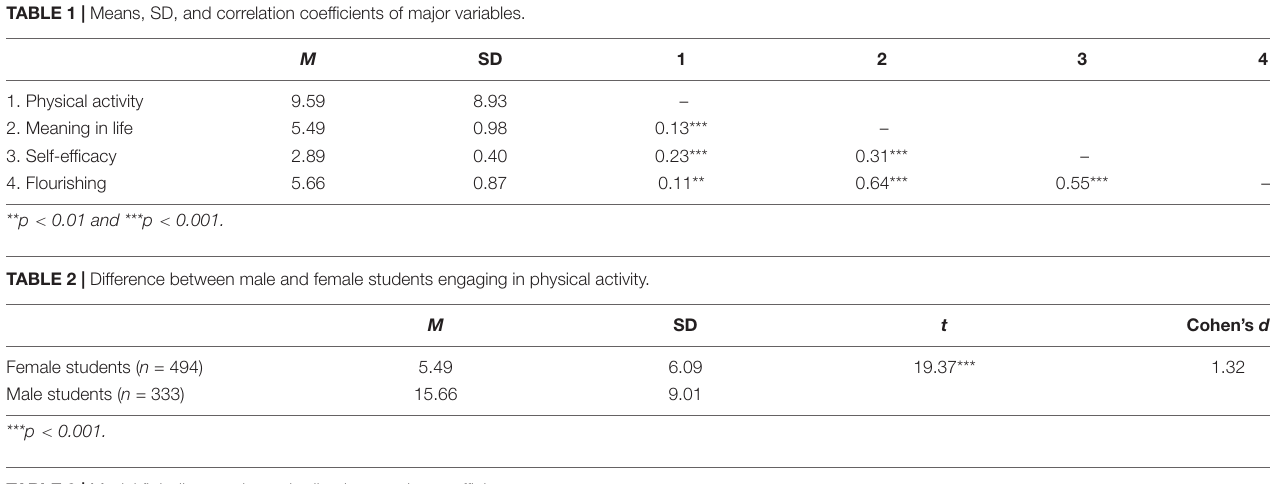
TABLE 3 | Model fit indices and standardized regression